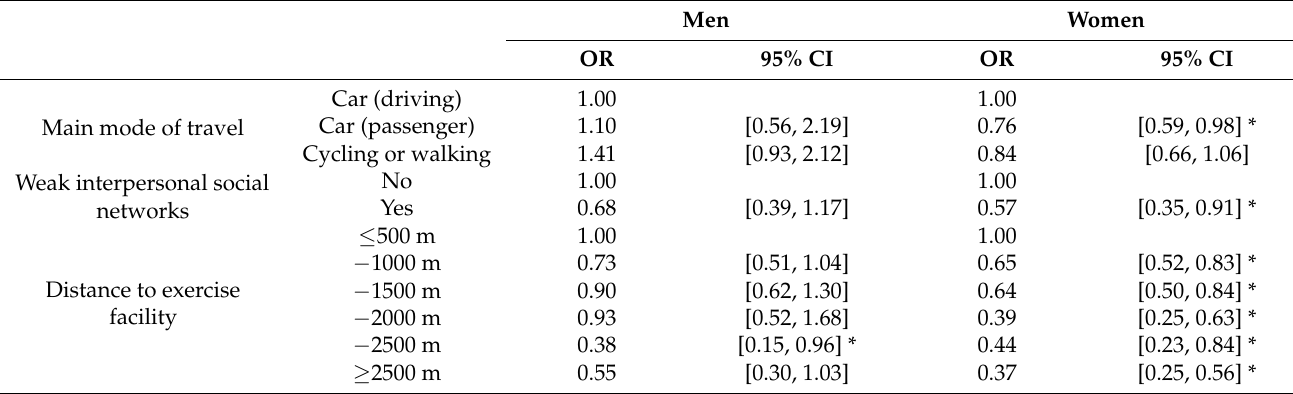
Table 2. Associations between participation in the silver-rehabili taisou exercise, interpersonal social networks, and distance to exercise facility.